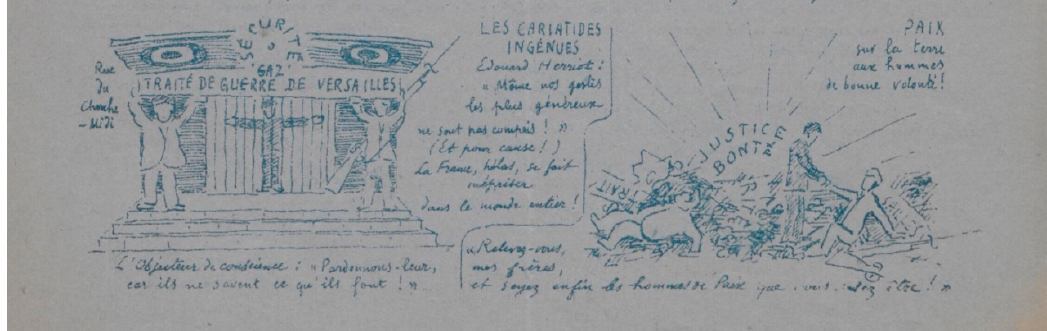
Figure 10. Les Pacifiques. 1932. Graphite on Paper. La Contemporaine. Fonds Duchêne. F Δ res 0235. Box 6. Folder 7.